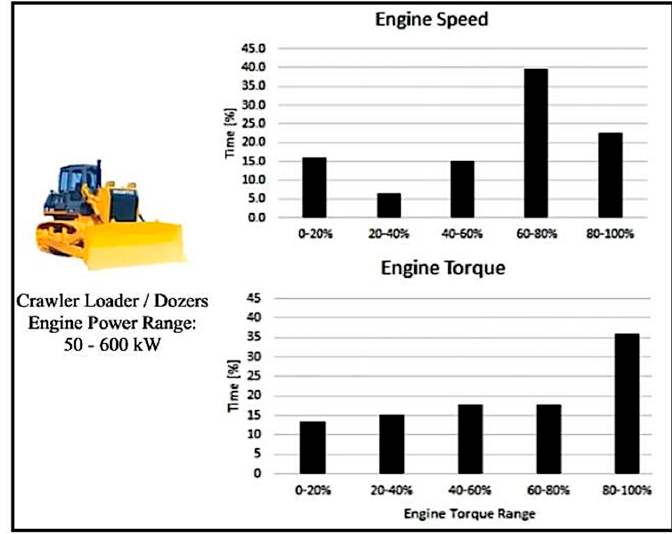
Figure 4. Typical HDDE time operational profiles.